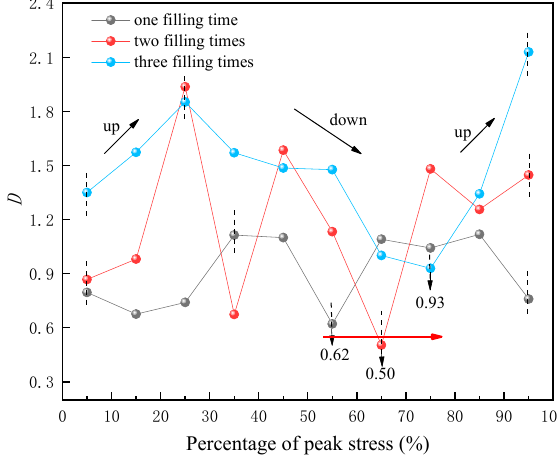
Figure 9. D of LCTB with different filling times.